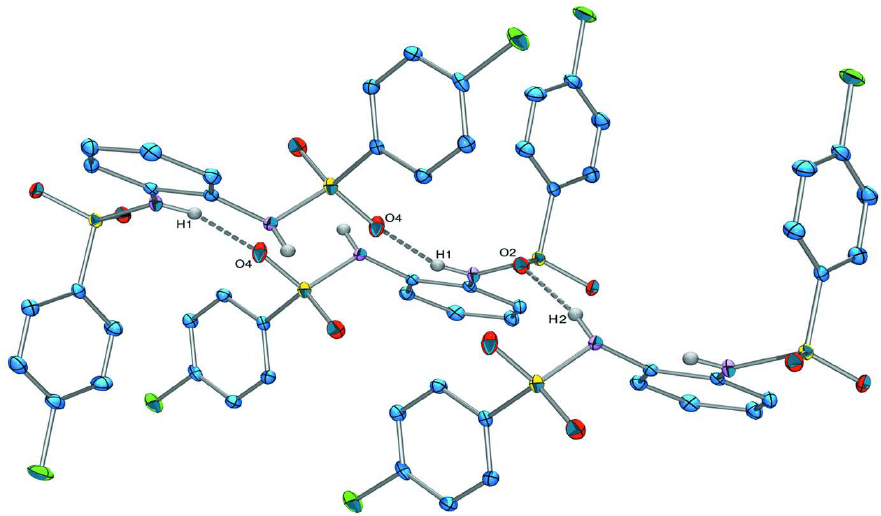
Crystal packing diagram of (I) showing the intermolecular H bonds present. H atoms not involved in H bonding are not shown. Displacement ellipsoids are drawn at the 30% probability